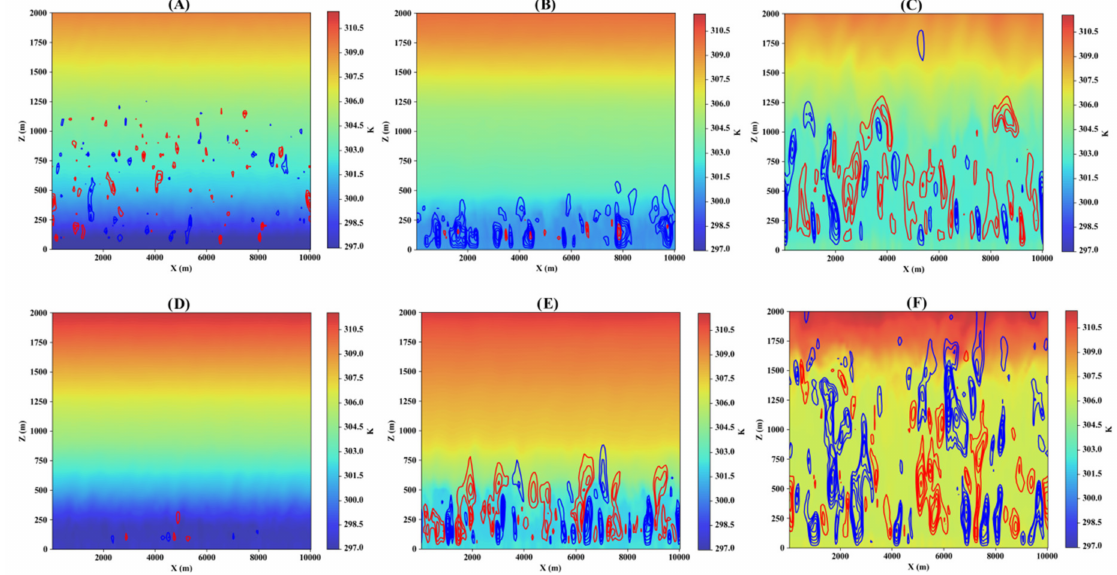
Figure 8. Plane x – z ( y = 5.0 km) of potential temperature (K) and vertical wind contours (m s − 1 ), colors (line) representing upward (blue) and downward (red) movements, at different times of the day for ( A – C ) IOP 3 and ( D – F ) IOP 4, where the local time is ( A , D ) 04 LT, ( B , E ) 08 LT, and ( C , F ) 10